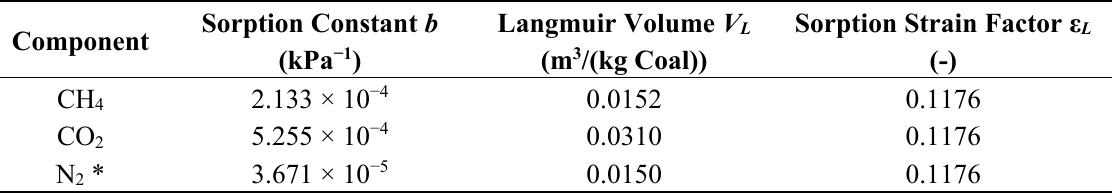
Table 2. Langmuir constant for sorption and swelling isotherms.